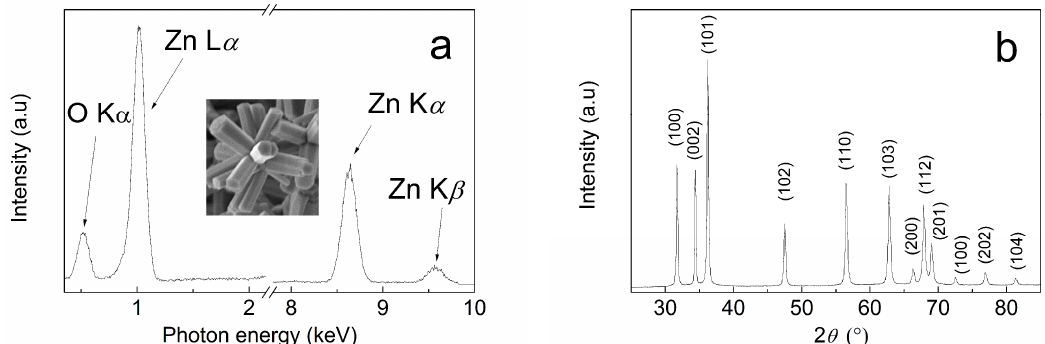
Figure 3. Energy dispersive spectrum ( a ) and X-ray diffraction spectrum ( b ) of ZnO star-like particles. Inset of the Figure 2a is the area from which the energy-dispersive spectroscopy (EDX) was collected.